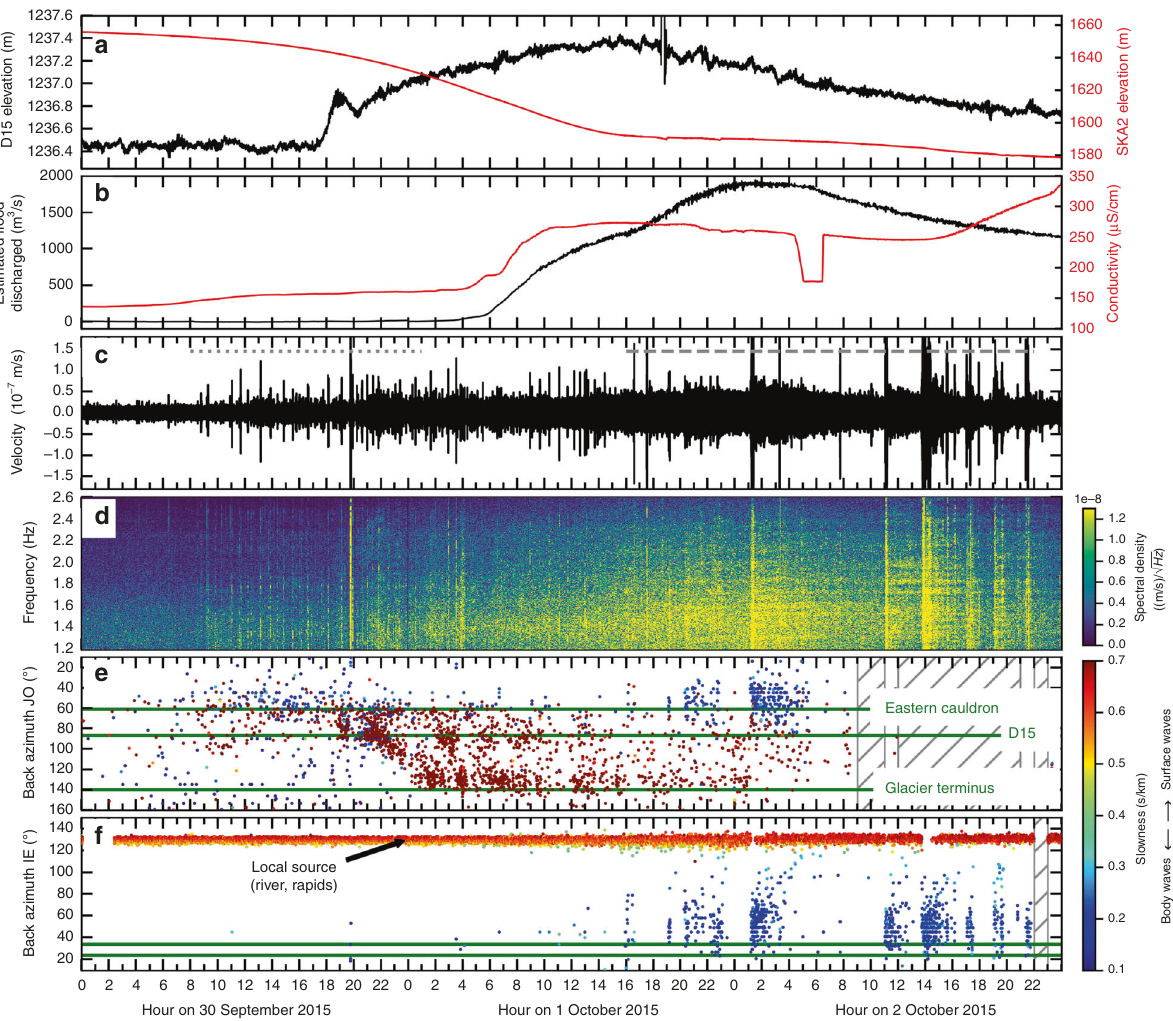
Fig. 2 Tracking a large fl ood from the eastern Skaftá cauldron from 30 September to 3 October 2015. a Elevation of the GPS instruments on top of the cauldron (SKA2, red) and 15 km from the ice terminus (D15, black) as measured above the GRS80/WGS84 ellipsoid (67.23 m at D15 and 67.72m at SKA2). b Conductivity (red) and estimated fl ood discharge (black) in Skaftá river measured at Sveinstindur. c Vertical velocity seismogram of JO station JOK, where the grey dotted and the grey dashed line mark time windows of Type 1 tremor and Type 2 tremor, respectively and (d) amplitude spectrogram of sub fi gure c made with a fast Fourier transform window length of 512 s and 50% overlap. e Dots indicate the dominant back azimuth at JO array coloured according to slowness. Green lines mark the direction of the eastern cauldron, the location of D15 and the glacier terminus out fl ow as in Fig. 1. Hatched times mark multiple hour long data gaps on more than four stations preventing array processing. The mean uncertainty caused by the array geometry is 4.2° (standard deviation 2.5°) in back azimuth and 0.04 s/km (standard deviation 0.01 s/km) in slowness. f Same as sub fi gure e but for IE array where green lines mark the back azimuth of the eastern cauldron and D15 (top and bottom, respectively). The mean uncertainty is 3.0° (standard deviation 1.1°) in back azimuth and 0.03 s/km (standard deviation 0.01 s/km) in slowness. Note that the recordings at IE array are dominated by local, surface wave noise known to be from nearby rivers and rapids (indicated by large slowness values). In comparison to this noise, Type 1 tremor is too weak to be detected by the array. However, the amplitude of the Type 2 tremor is larger than the local noise source and was recorded and located (indicated by small slowness